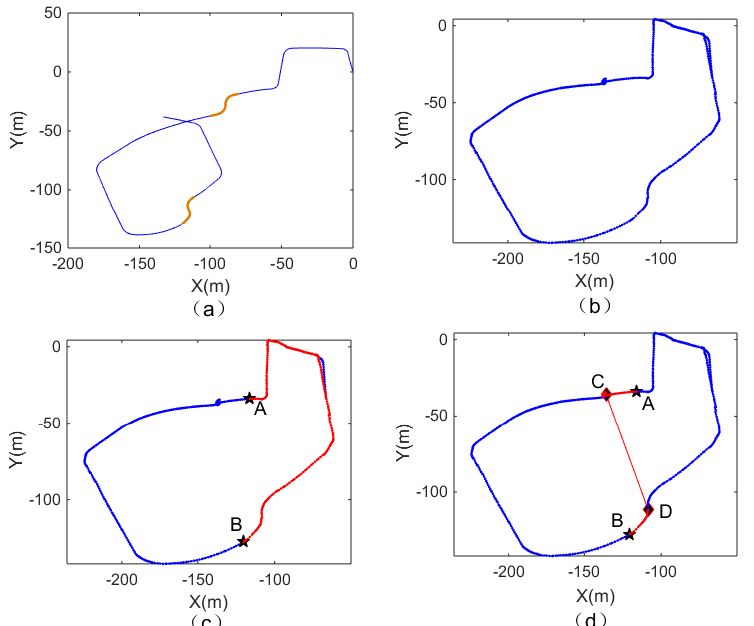
Figure 13. The output of the RatSLAM algorithm and the path planning results before and after the integration of the connectivity network of the second scene. ( a ) Output of the visual odometer. ( b ) Experience map of the first scene. ( c ) Path planning based on episodic memory. ( d ) The optimal path planned after introducing the connectivity network.